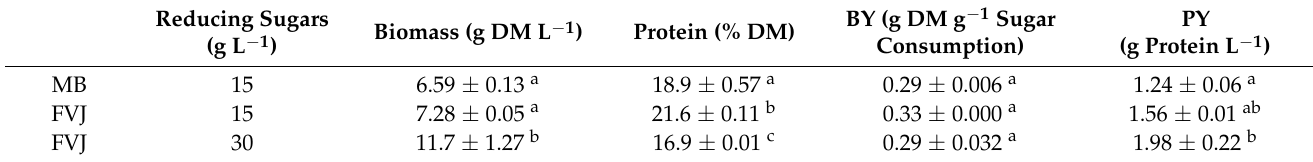
Table 4. Effect of medium and sugar concentration on biomass (g DM L − 1 ), protein (% DM),